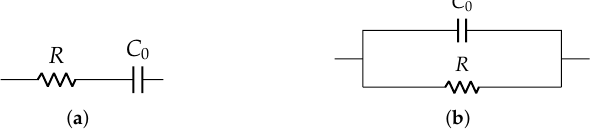
Figure 4. Park model: ( a ) series and ( b ) parallel.